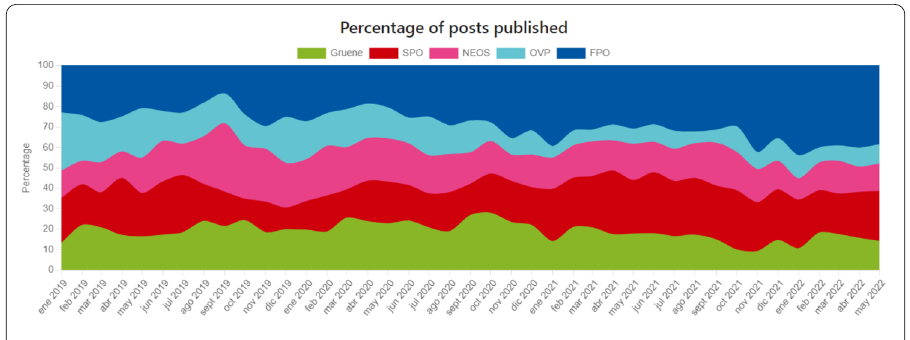
Figure 11 Percentage of pots published by each party in Austria